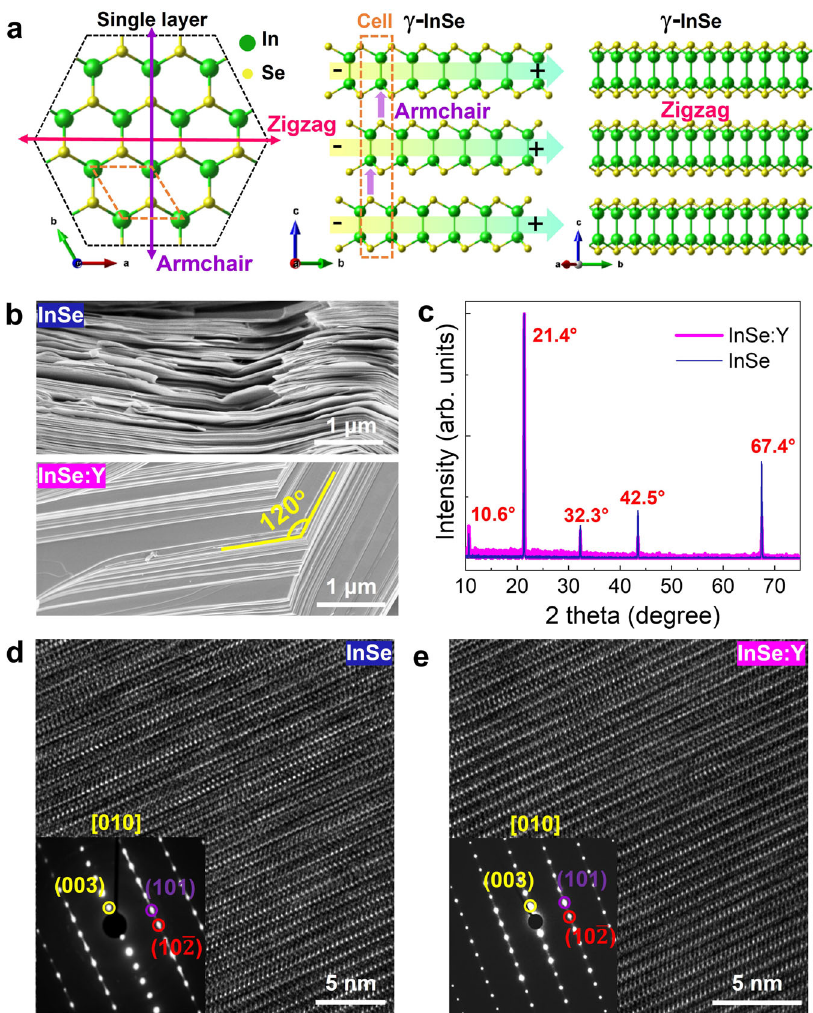
Fig.1|StructuralcharacterizationofInSeandInSe:Y.a SchematicsofInSesingle layer and the atomic arrangement of γ -InSe, demonstrating the IP polarization alongtheACdirectionand theOOP polarizationalong thethickness-direction(see